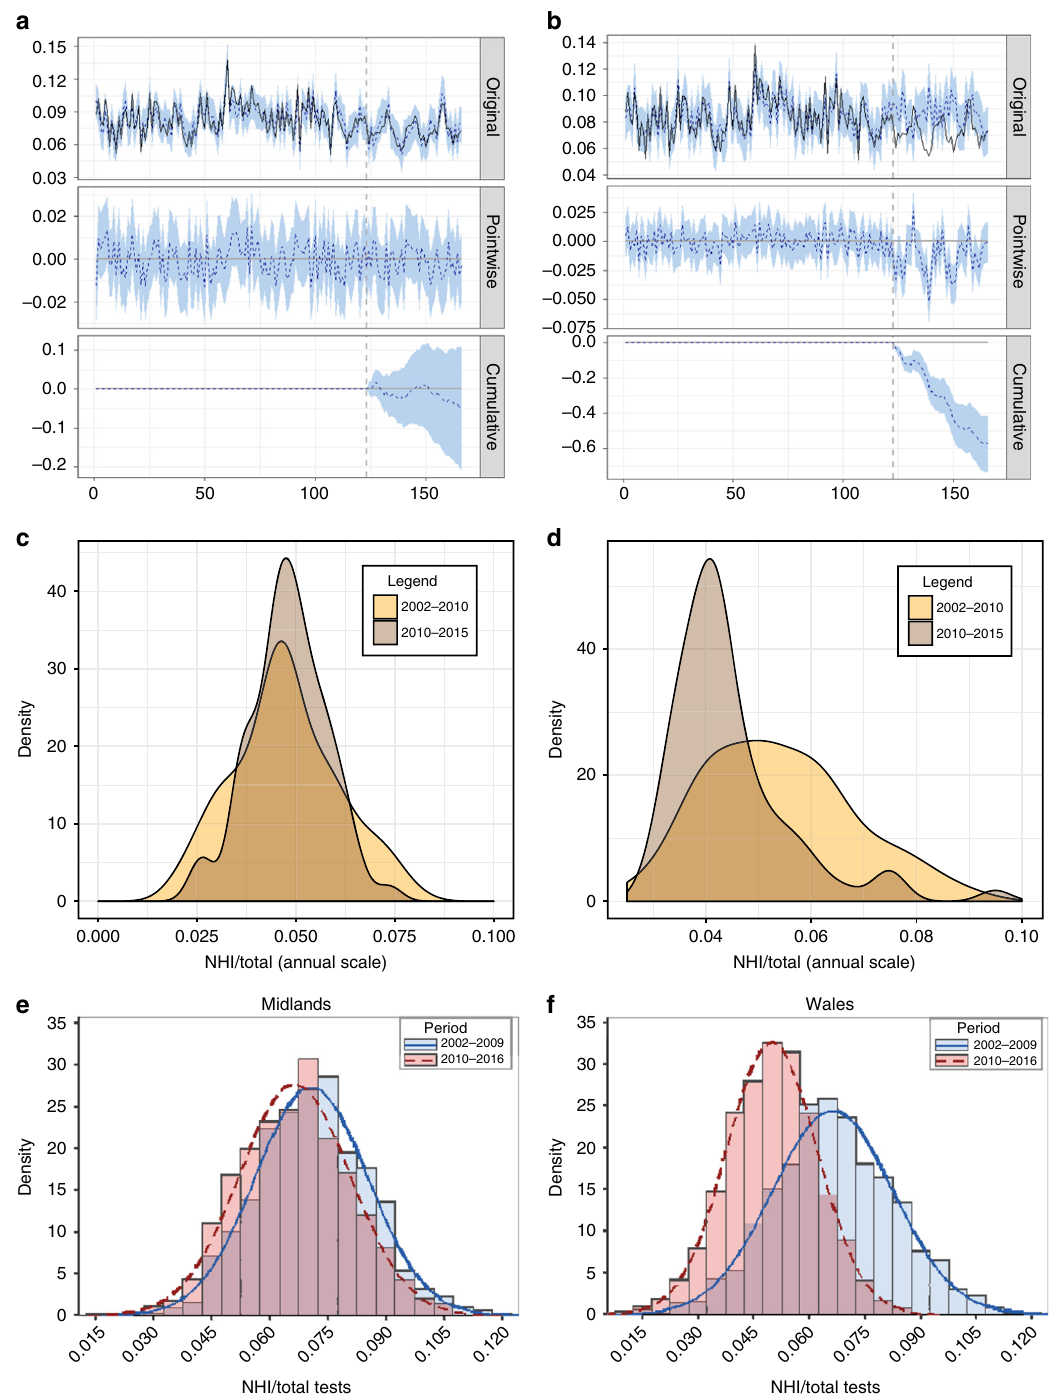
Fig. 4 Comparing data and IBM outputs. a ΝΗΙ / ΤΤΗ data and IBM outputs comparisons for English high risk and edge areas after testing interruption with Bayesian inference time series intervention analysis. The ‘ intervention ’ point is January 2013 when annual testing was introduced. Analysis for scenario I – testing switched from 4 years to annual in the IBM (test) as it happens in the data (control). The fi rst panel shows the actual test values (black line) against the forecast (counterfactual prediction for the post-intervention period) in a dotted blue line. In all three panels 95% prediction con fi dence intervals are indicated with shaded light blue colour. The intervention point is indicated with a vertical dashed back line. The second panel shows the difference between observed data and counterfactual predictions. This is the pointwise causal effect, as estimated by Bayesian analysis. The third panel adds up the pointwise contributions from the second panel, resulting in a plot of the cumulative effect of the intervention. b Same as a for scenario II – testing every 4 years throughout the IBM simulation (test) against the same data (control). c Empirical probability densities for NHI/TTH data in English Midlands after the interruption but before the implementation of at least annual testing (2002 – 2009, yellow colour) and after at least annual testing frequency implementation in Wales (2010 – 2016, brown colour). d Same as c for Wales. e the empirical probability densities of NHI/TTH from outputs of the parameterised IBM for Midlands. f Same as e for